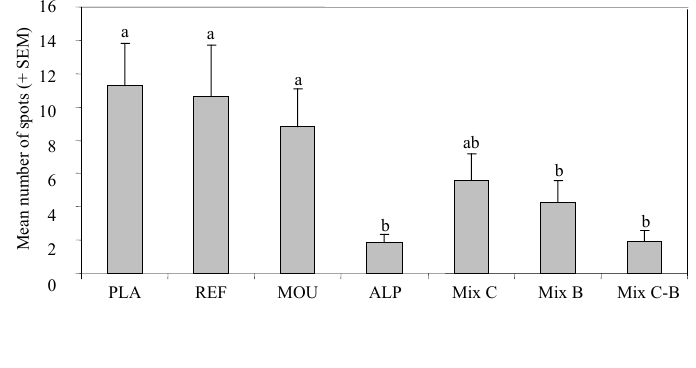
Figure 3. Mean annual number of infestation spots recorded in different forest types every 1000 ha of spruce forest. Different letters indicate significant differences at p < 0.05. For the code legend, see Table 1.